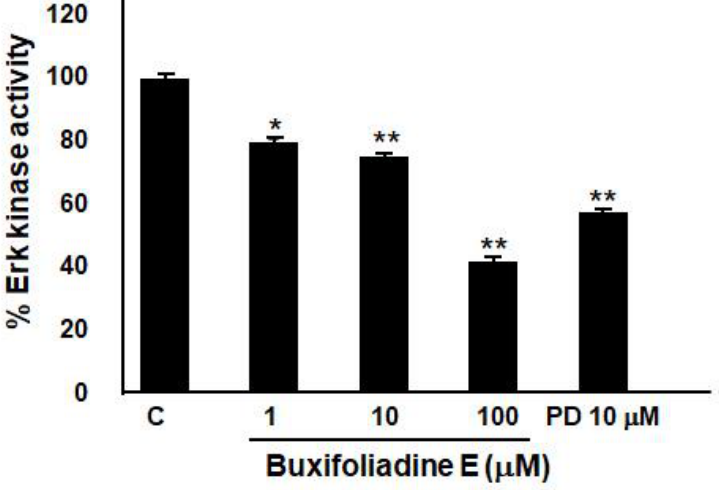
Figure 10. Effect of buxifoliadine E on Erk enzyme-kinase activity. * p < 0.05, ** p < 0.01.